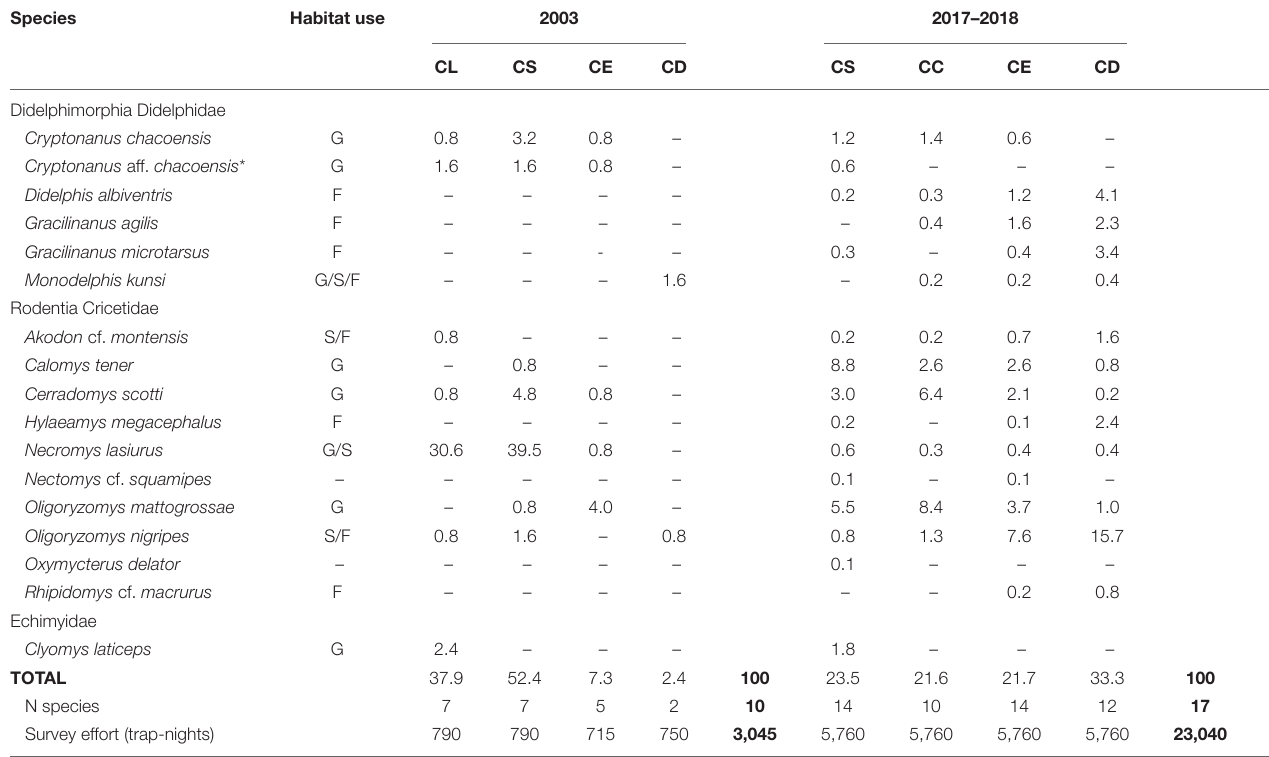
TABLE 2 | Relative abundance (%) of small mammals in the Santa Bárbara Ecological Station, São Paulo, Brazil, in the 2003 and 2017–2018 surveys. Species Habitat use